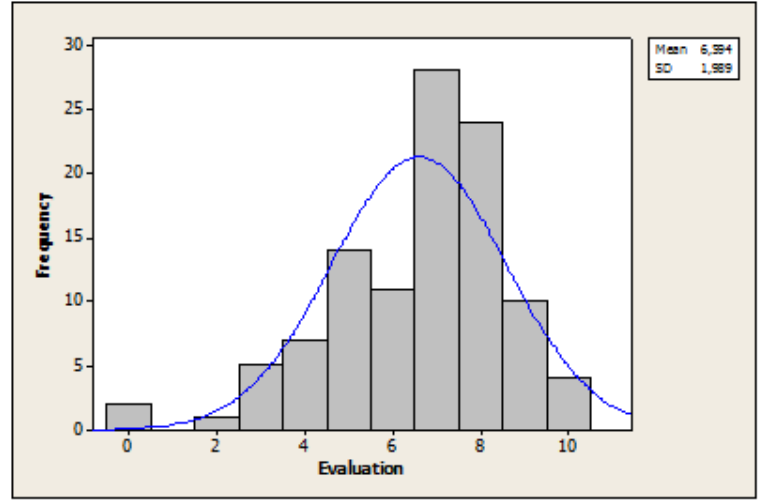
Figure 3. Assessment of the impact of the EXPLORE courses contents on the teaching practces of teacher partcipants on a scale from 0 to 10